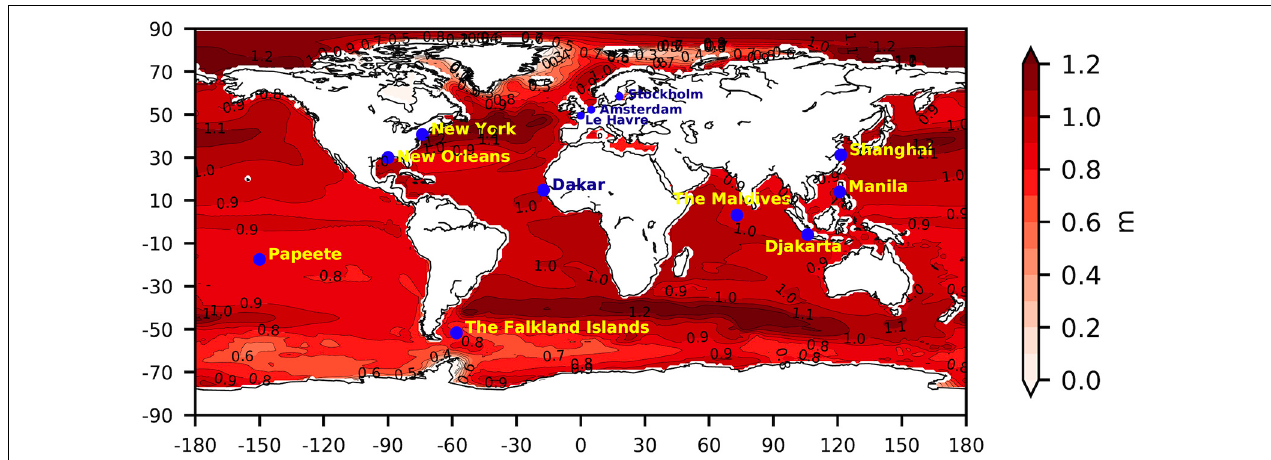
FIGURE 1 | Regional sea-level change (m) in 2100 relative to 1986–2005 in RCP8.5. The selected sites for discussing regional scenarios are represented by the blue circles. Each value for each grid cell corresponds to the upper-end of the likely range obtained from sea-level projections provided by the Integrated Climate Data Center (Carson et al.,